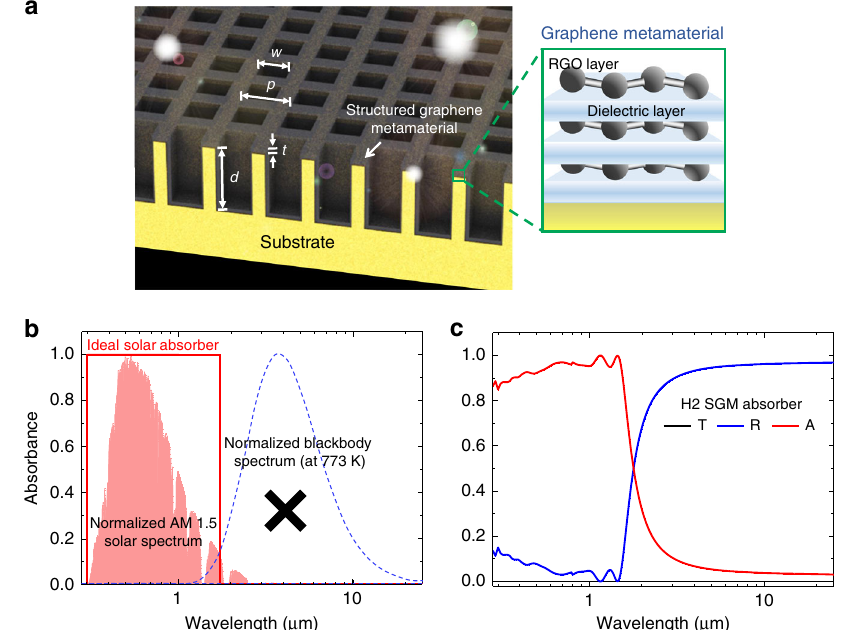
Fig. 1 SGM solar-selective absorber. a Schematic representation of the 3D SGM absorber, characterized by the structural parameters: the depth ( d ) of trenches, the thickness ( t ) of the graphene metamaterial layer, the width ( w ) of the hole, and the period ( p ) of the structure. Inset shows the structure of the graphene metamaterial. b Absorbance spectrum of ideal solar absorber. Ideal solar absorber is able to ef fi ciently absorb (near-unity) sunlight (shaded red) and minimize energy dissipation through thermal radiation (blue dash line). X indicates the blackbody thermal emission is inhibited. c Simulated spectral re fl ectance ( R ), transmittance ( T ), and absorbance ( A ) for the SGM absorber featuring a hole width of 0.59 µ m, a period of 0.8 µ m, a depth of trenches of 1 µ m, and a graphene metamaterial fi lm with a thickness of 30